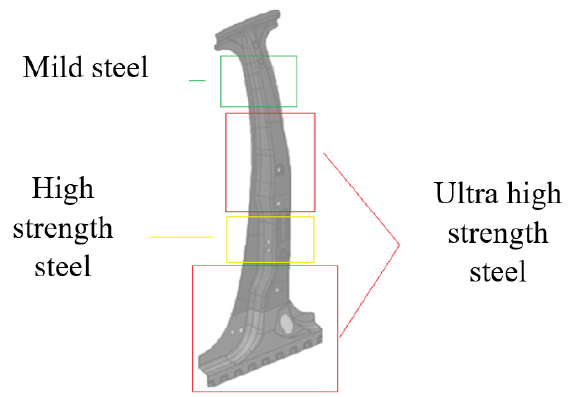
Figure 13. Type “B” pillar material structure and ideal cutting location (green area).